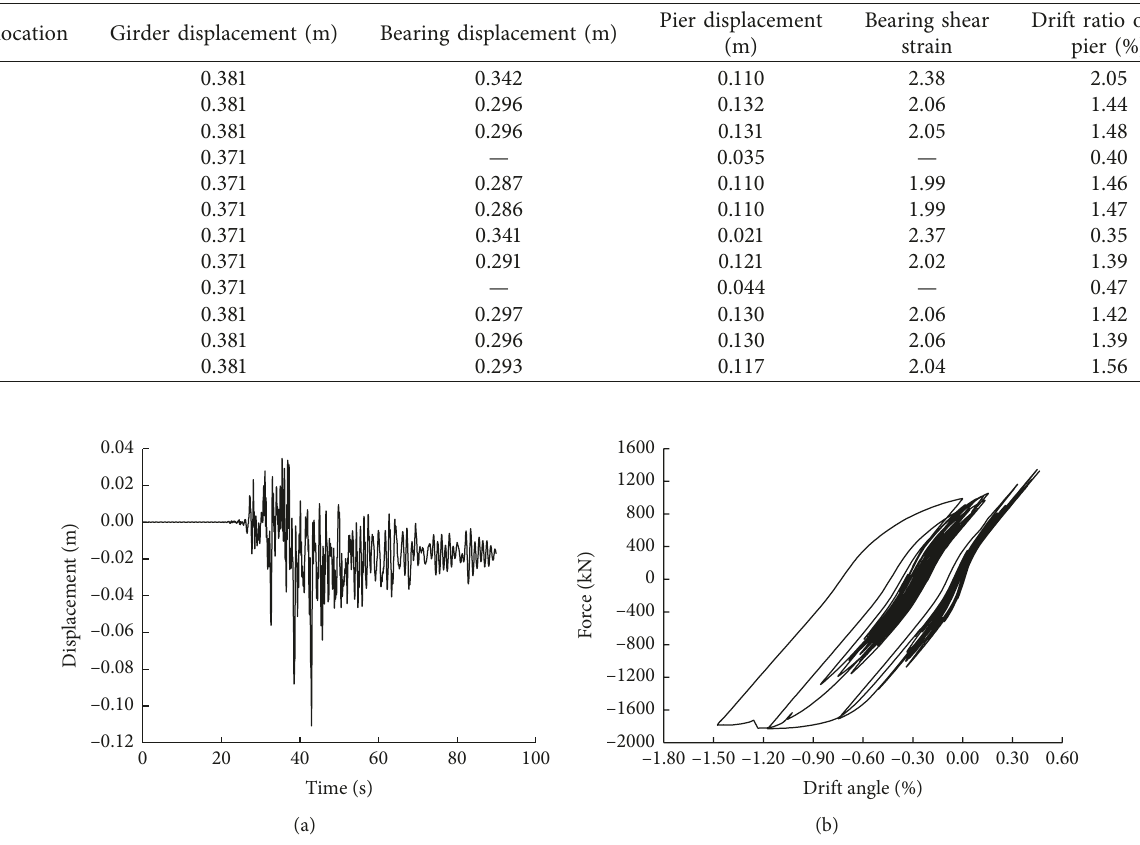
Table 4: Displacement response of seismically isolated bridge.